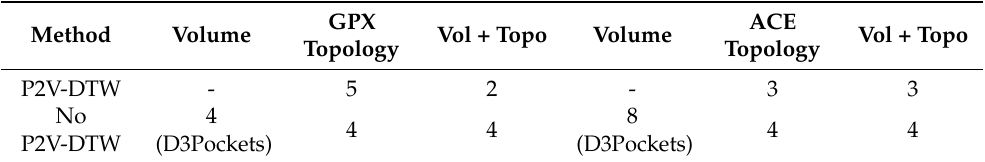
Table 2. Comparison of pocket similarity rank of calculation